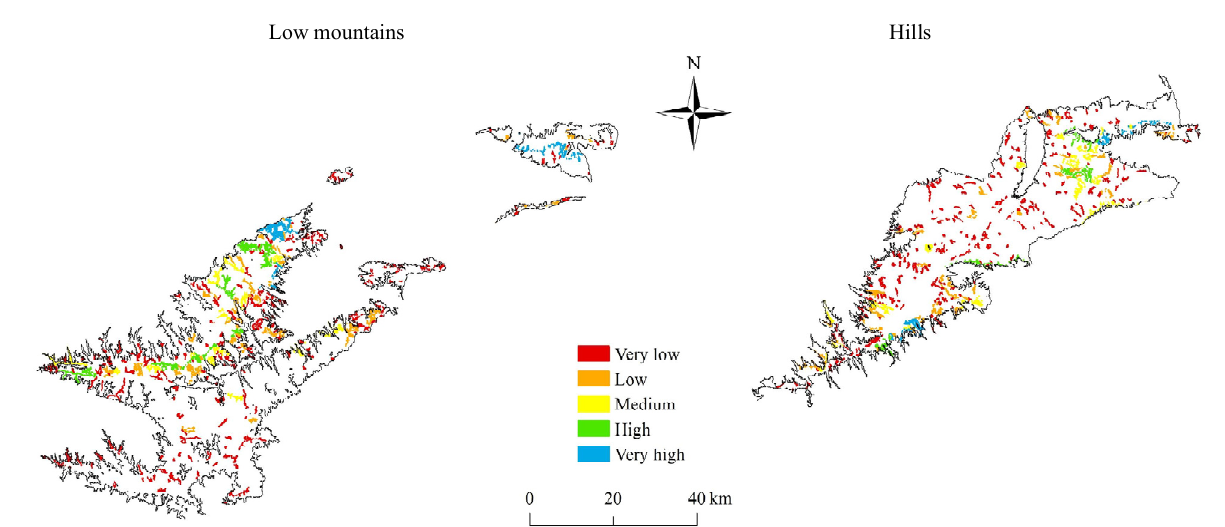
Figure 6. Contribution of reforested patches to the improvement of FLC.